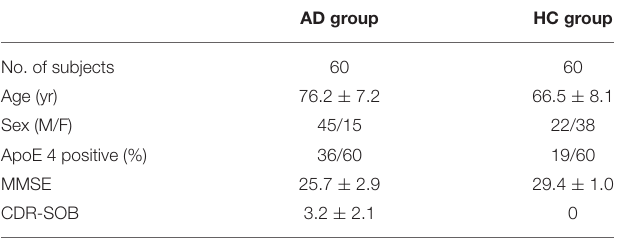
TABLE 1 | Demographic information of 120 subjects by group.